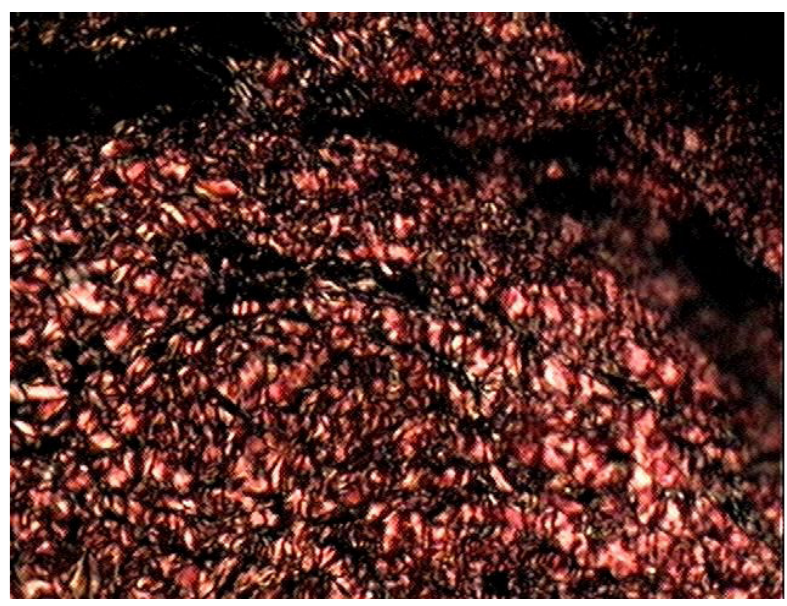
FIGURE 6 – Sample slide stained by picrosirius red demonstrating lamina proprias´ connective tissue after